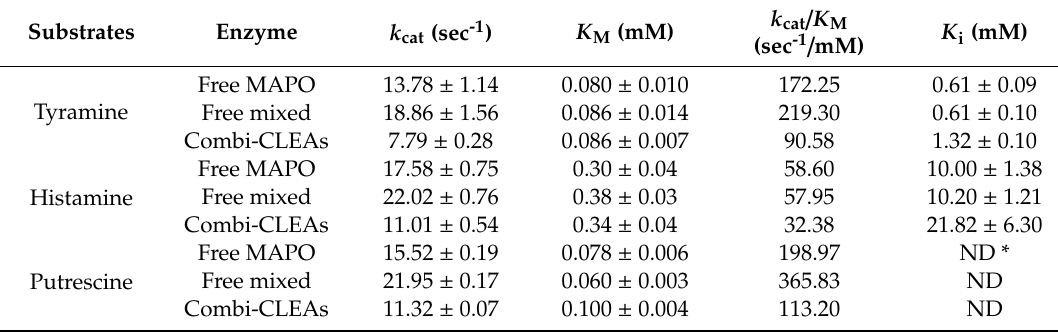
Table 2. Kinetic parameters of free and CLEAs enzymes for various substrates.